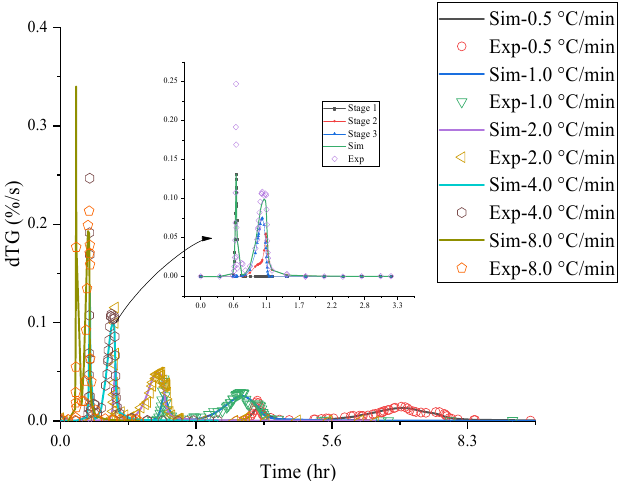
Figure 5. Mass loss rate of AIBA between TGA and nonlinear fitting results which contained multi-stage reactions by analyzing the experimental and simulated values of a single heating rate 4.0 °C/min along with other heating rates at 0.5, 1.0, 2.0, and 8.0 °C/min. Table 2. Thermokinetic parameters evaluation results of the AIBA.